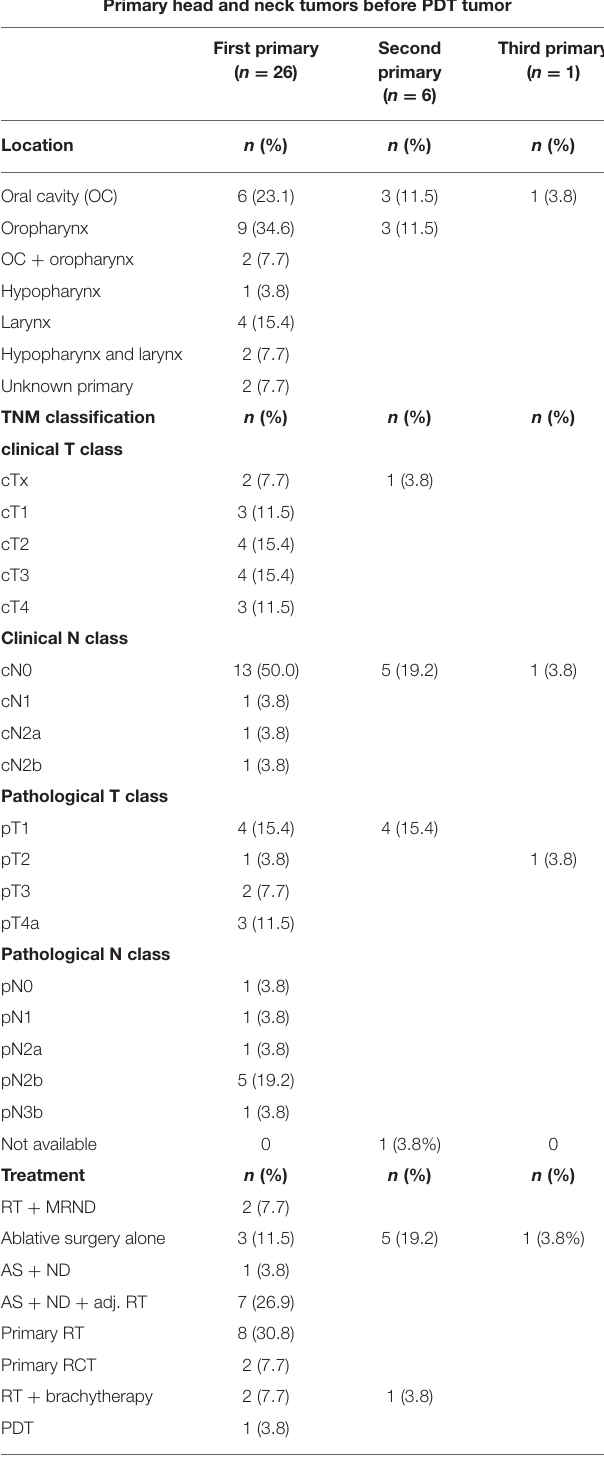
TABLE 3 | Tumor characteristics of head and neck SCC recurrences before diagnosis and treatment of PDT tumor in 26 patients. Recurrences before PDT